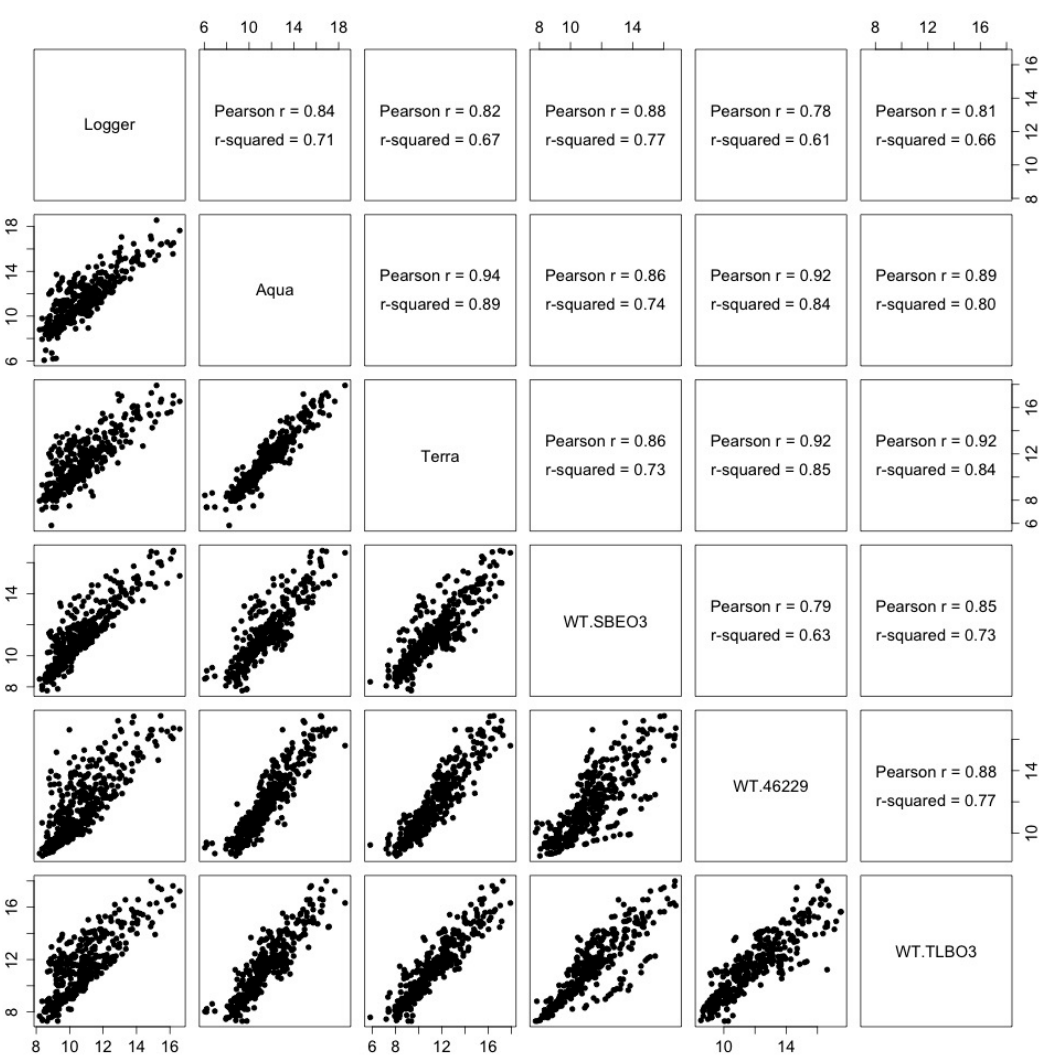
Figure 4. Correlation matrix with scatterplots showing the relationship between submerged mussel logger temperature and the water temperature estimate at the Yachats Beach study site. The scatterplots are shown in the lower left portion of the figure. The Pearson r correlation coefficients and r-squared values are shown in the upper right portion of the figure.